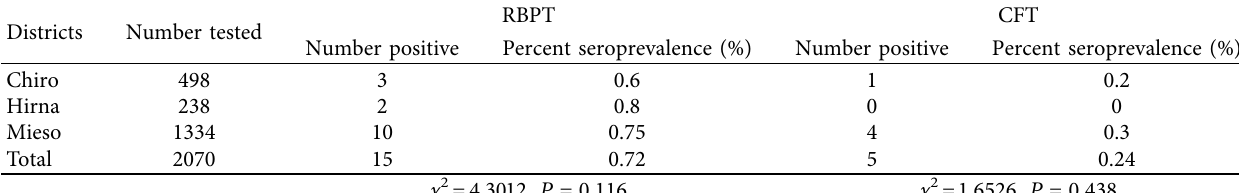
Table 1: The overall seroprevalence of small ruminant brucellosis in study districts.